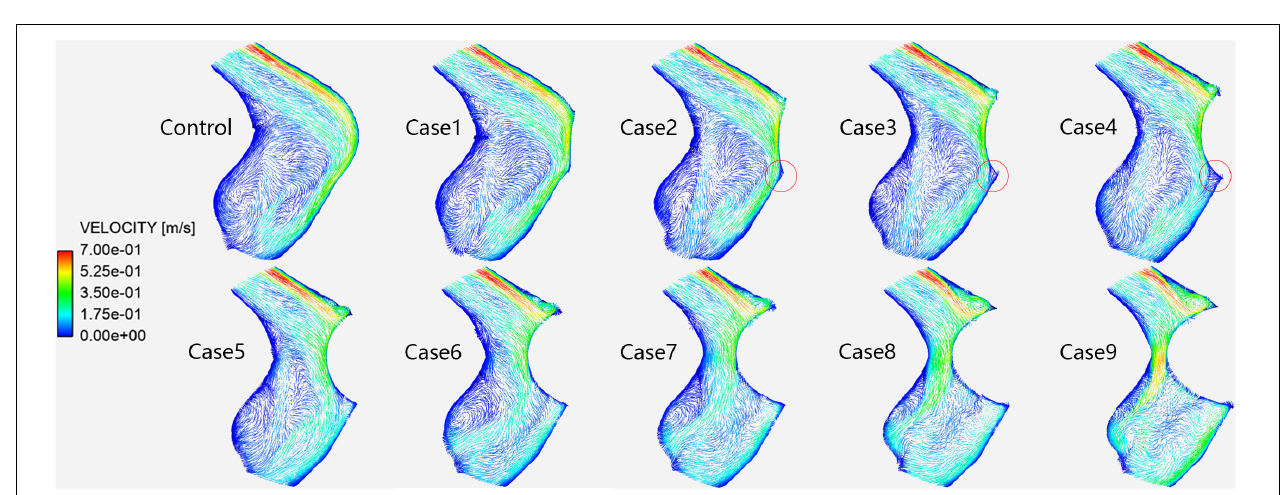
FIGURE 5 | Velocity vectors in each case at the prominent transverse-sigmoid sinus junction (PTSJ). The red circles represent the blood stasis